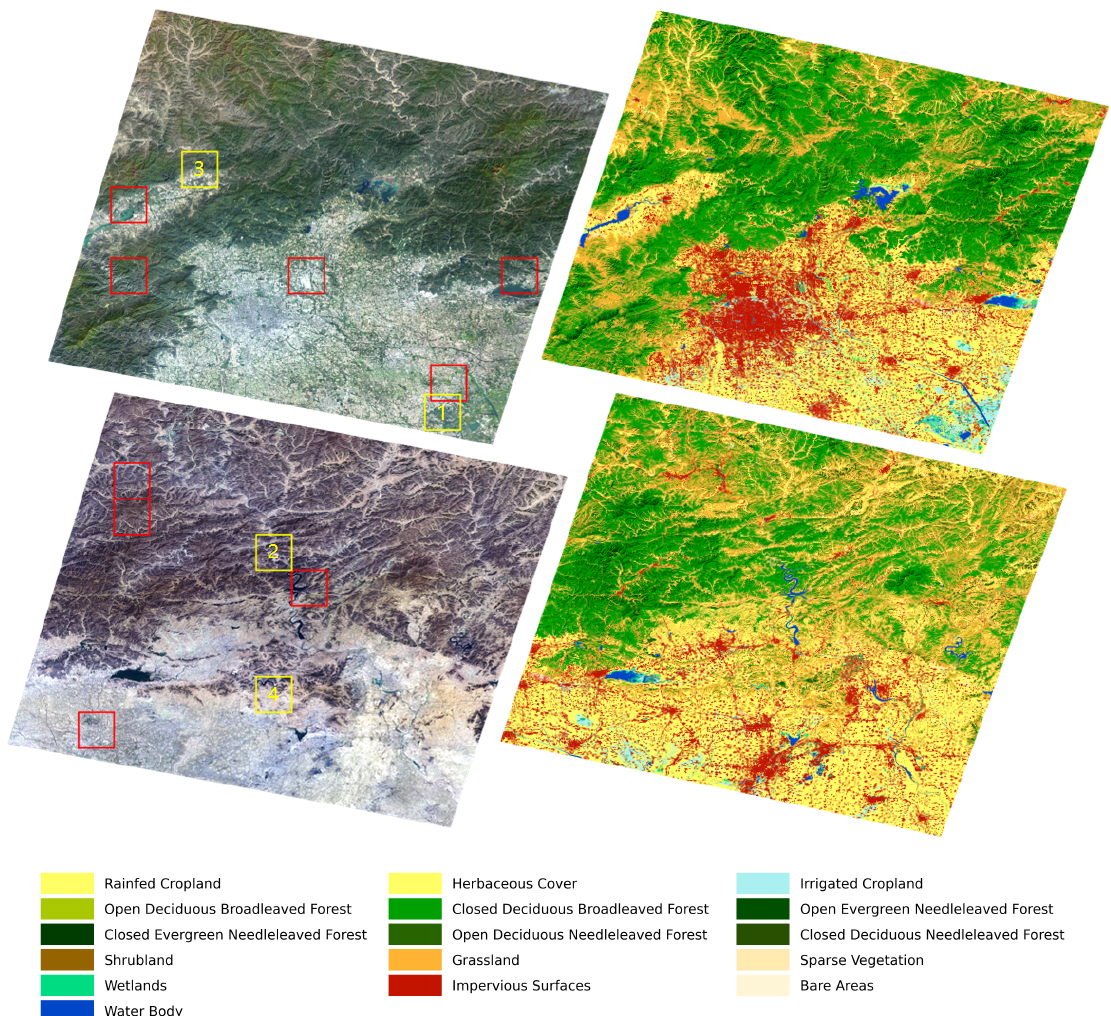
Figure 7. Example images and the classification maps generated by the proposed SKNN-LB-DTW method. The date of the first image is 6 October, and the second is 26 March 2016. Red squares locate the grids used in Figure 8 for visual comparisons, and yellow squares locate the grids used for statistical evaluations with their ordinal